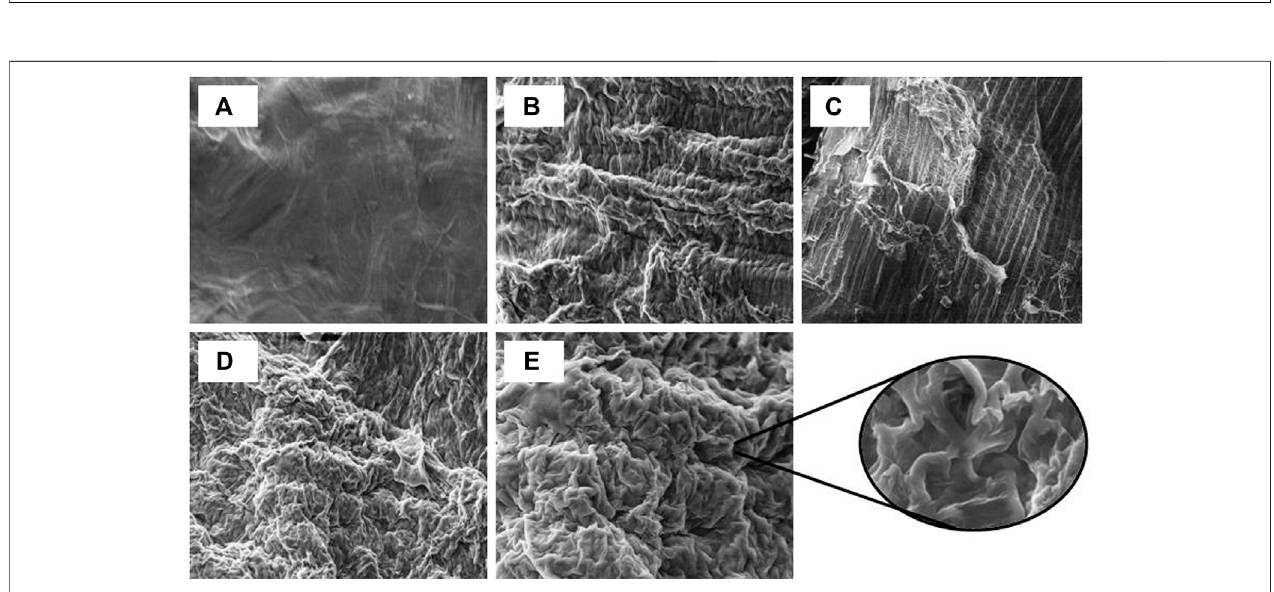
FIGURE 6 | Scanning electron micrographs of different chemical-treated residues, (A) raw corn cob biomass, (B) NaOH-pretreated residues, (C) NH 3 -pretreated residues, (D) HNO 3 -pretreated residues, and (E) NaOH-pretreated and acid-hydrolyzed residues with magni fi cation.